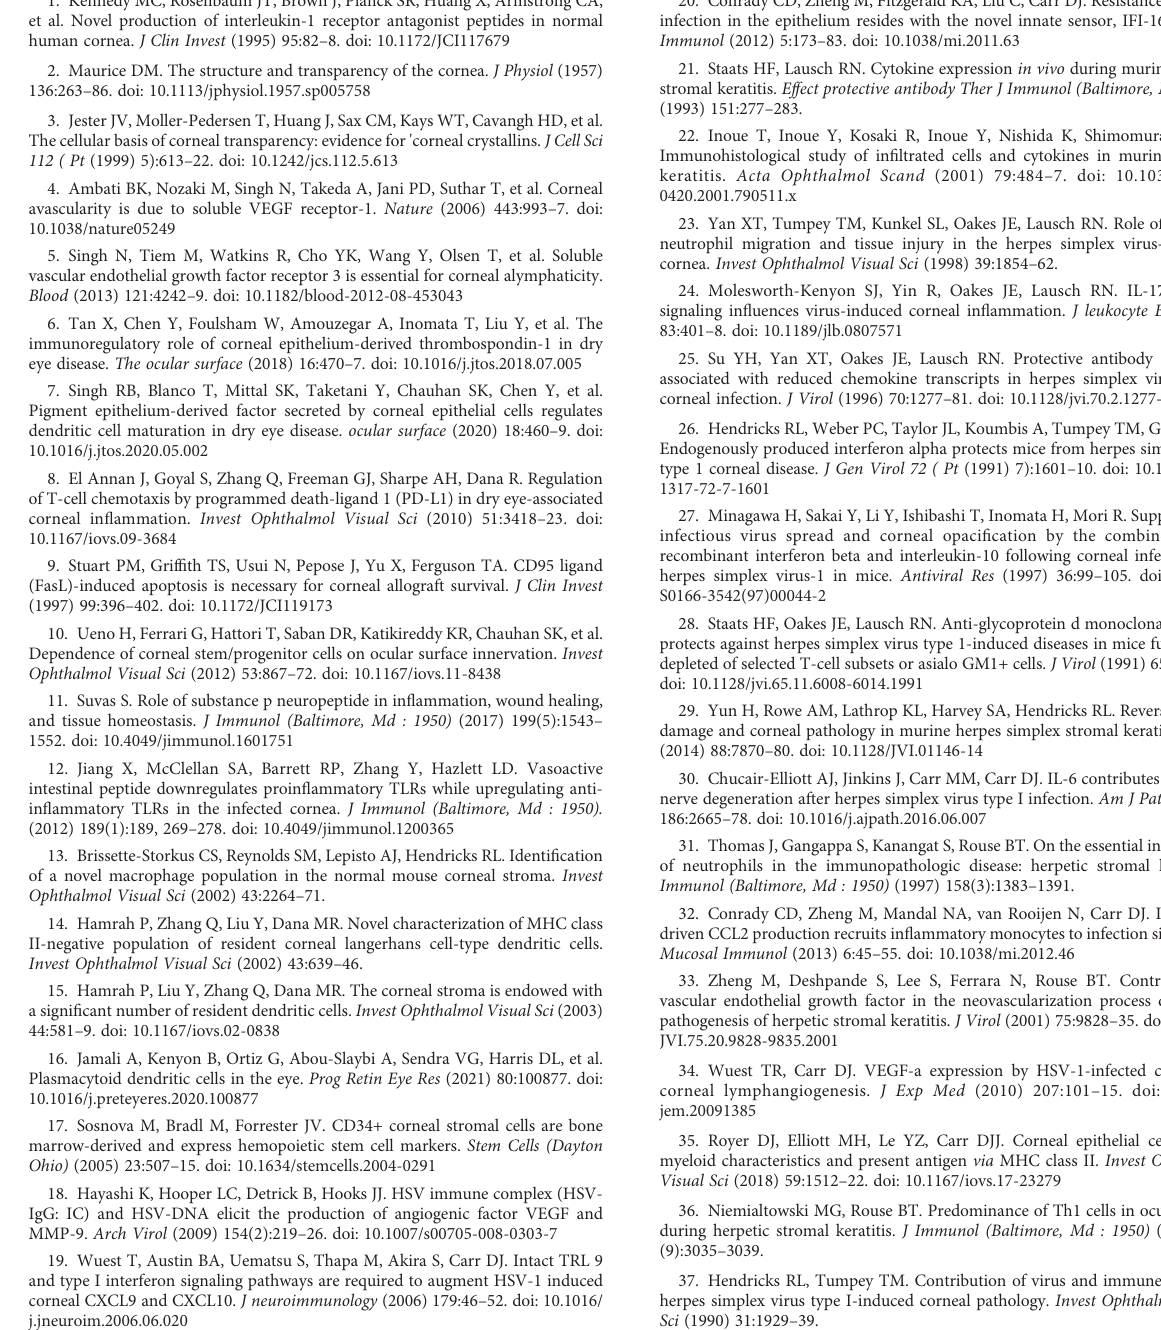
SUPPLEMENTARY FIGURE 1 Wild type and OPN KO mice exhibit equivalent polyfunctional CD8 + T cell response during acute ocular HSV-1 infection. Data generated from was used to assess for polyfunctionality of CD8 + T cells using SPICE software with the results presented as pie charts in panel (A) . The average percentage of HSV-1 gB-speci fi c CD8 + T cells expressing CD107a, IFN-